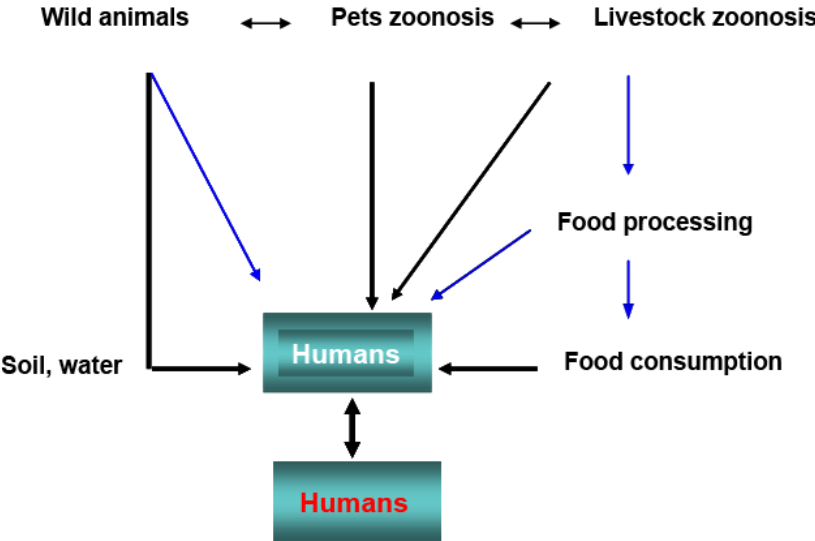
Figure 1: Main routes of transmission of antibiotic-resistant bacteria. Thick black arrows indicate the major routes, whereas thin blue arrows point to minor, but relevant ways of acquisition. A significant route of spreading the bacterial infections is from infected (red) to healthy (white)